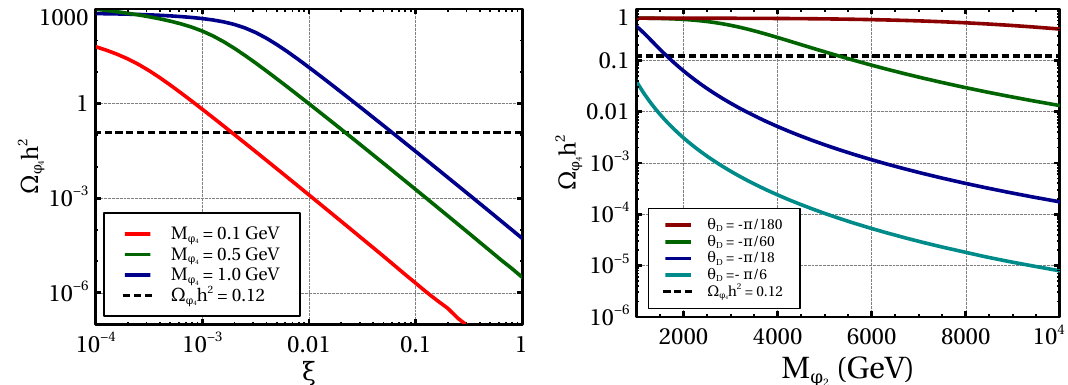
(b) Variation of Ω φ values of θ D .